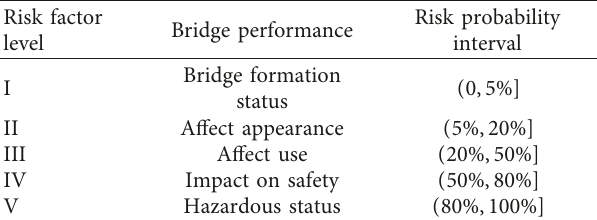
Table 1: Structural condition classes of existing railway